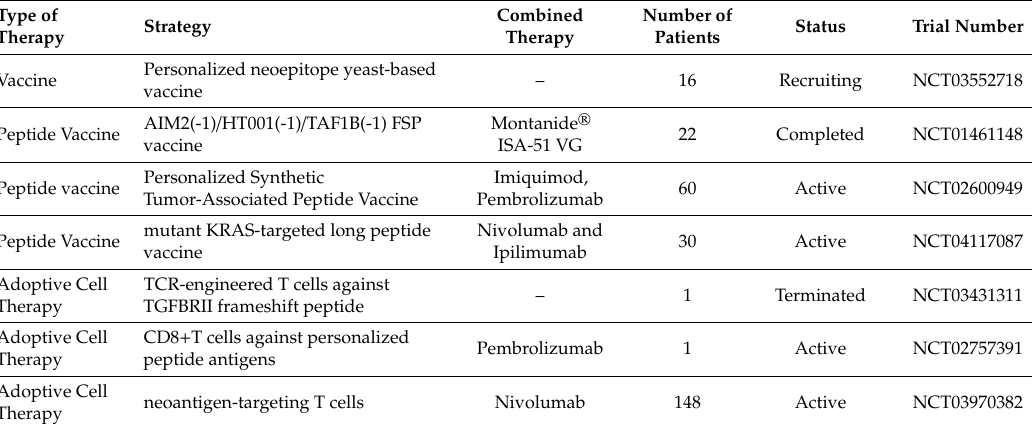
Table 3. List of clinical trials using tumor-specific antigens for CRC in their